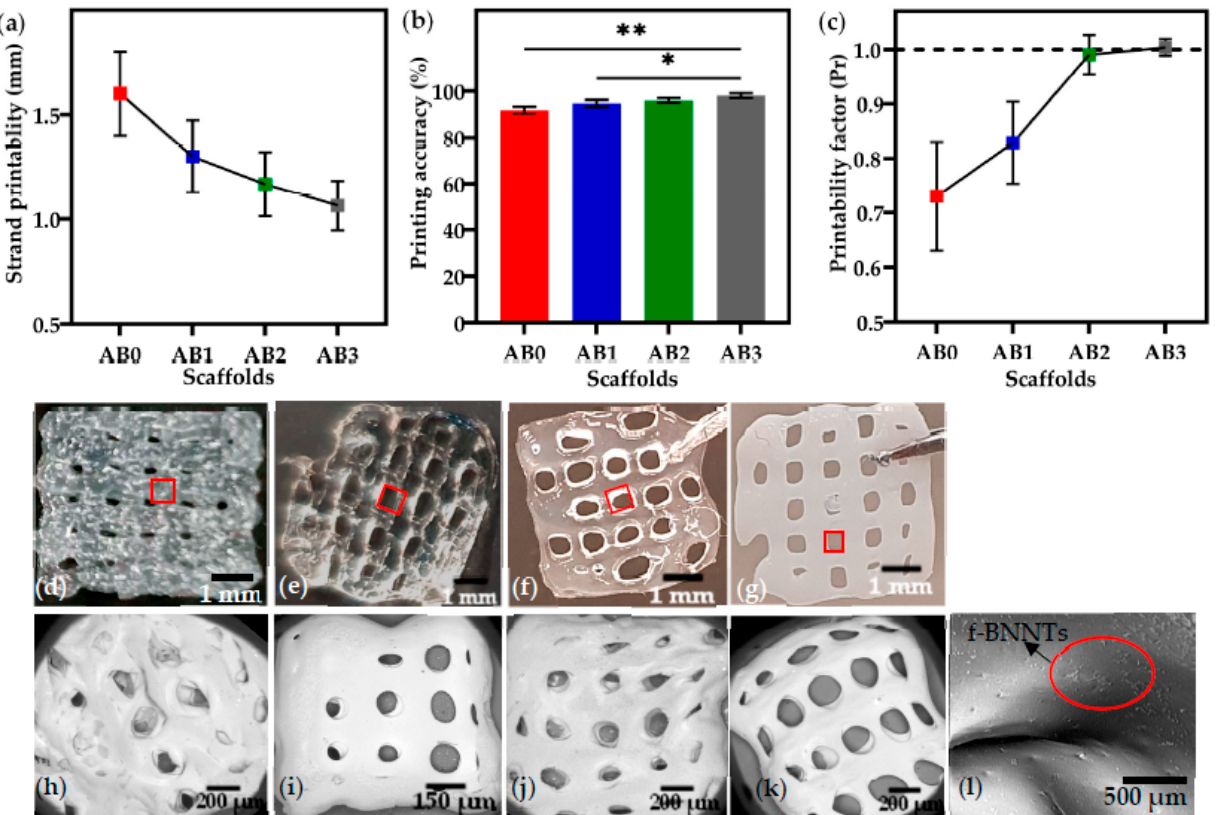
Figure 7. ( a ) Strand printability of ink solutions; ( b ) printing accuracy of ink solutions (** p < 0.01, * p < 0.05; n = 3); ( c ) printability factor (Pr) of ink solutions; images of scaffold ( d ) AB0; ( e ) AB1; ( f ) AB2; ( g ) AB3; SEM images of scaffold topography ( h ) AB0; ( i ) AB1; ( j ) AB2; ( k ) AB3; ( l ) AB3 (higher magnification with BNNTs dispersion in scaffold).